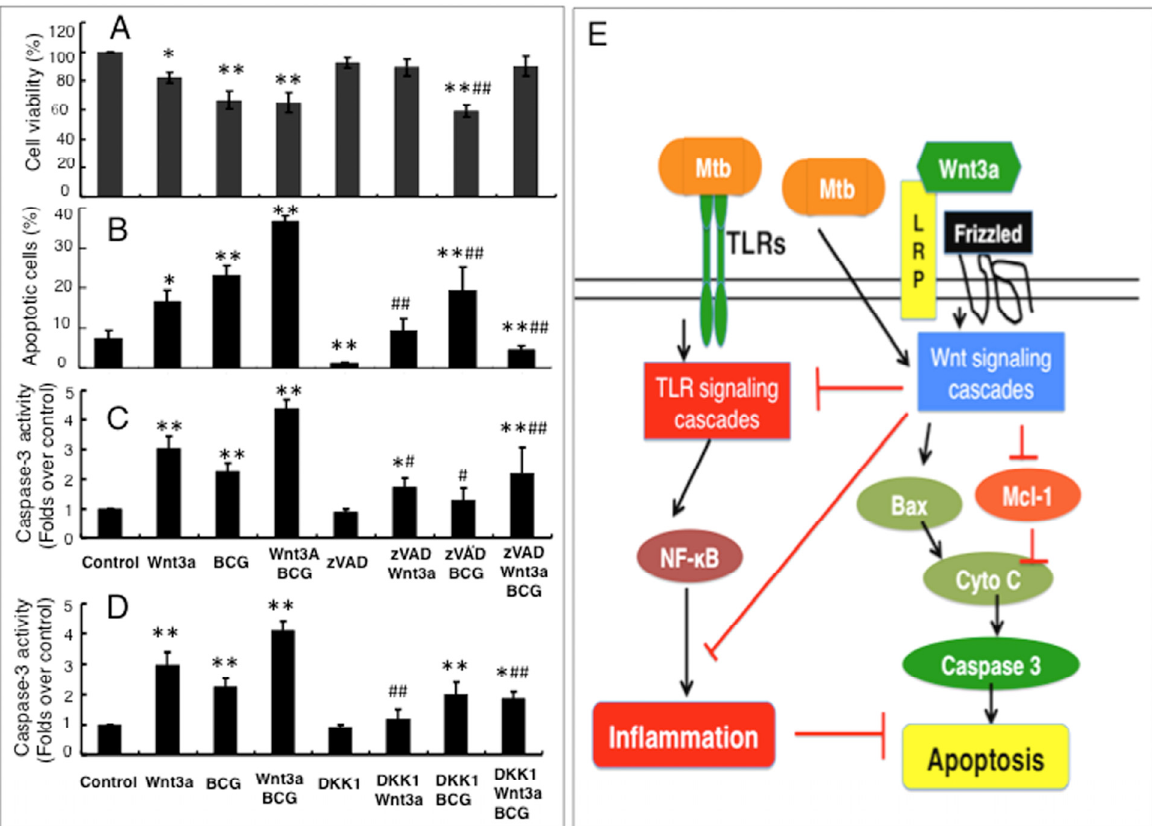
Figure 5. Wnt/ β -catenin promotes BCG-infected RAW264.7 cell apoptosis is in part through a caspase-dependent pathway. A caspase-dependent apoptotic pathway was examined in the RAW264.7 cells treated with Wnt3a, BCG, pan caspase inhibitor zVAD, and/or Wnt signal inhibitor DKK1. ( A ) Cell viability determined by an MTT assay for RAW264.7 cells treated with indicated conditions for 6 h; ( B ) Apoptotic cell fraction determined by a flow cytometric assay for RAW264.7 cells treated with indicated conditions for 24 h; ( C ) Relative caspase activity of RAW264.7 cells treated with indicated conditions containing pan caspase inhibitor zVAD for 24 h; ( D ) Relative caspase activity of RAW264.7 cells treated with indicated conditions containing Wnt signal inhibitor DKK1 for 24 h. Compared to a naïve control, * p < 0.05; ** p < 0.01; compared to the cells treated with zVAD (C) or DKK1 (D) alone, # p < 0.05; ## p < 0.01. Data represented the mean ± SD from three independent triplicate experiments ( n = 15); and ( E ) A proposed mechanism whereby the regulatory role of Wnt/ β -catenin signaling in the apoptosis macrophages upon mycobacterial infection. In this model, upon invasion of mycobacteria, the pathogen is first recognized by TLRs of the cells, which in turn triggers the TLR signaling cascade to initiate inflammatory response and activates Wnt/ β -catenin signaling that plays a negative feedback inhibitory role in modulation of inflammatory responses. Meanwhile, the activation of the Wnt/ β -catenin pathway subsequently promotes apoptotic cell death in the mycobacteria-infected macrophages, in part through a caspase-dependent apoptosis